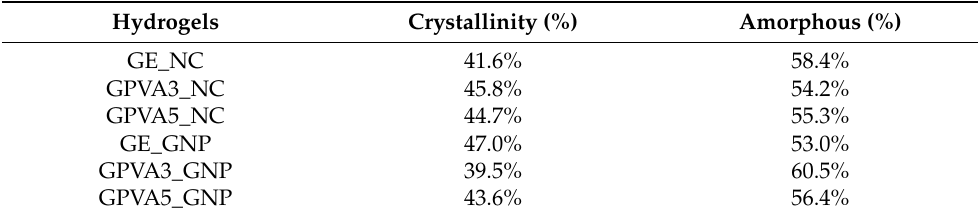
Table 1. Crystallinity and amorphous levels in GPVA hydrogels via XRD analysis. Hydrogels